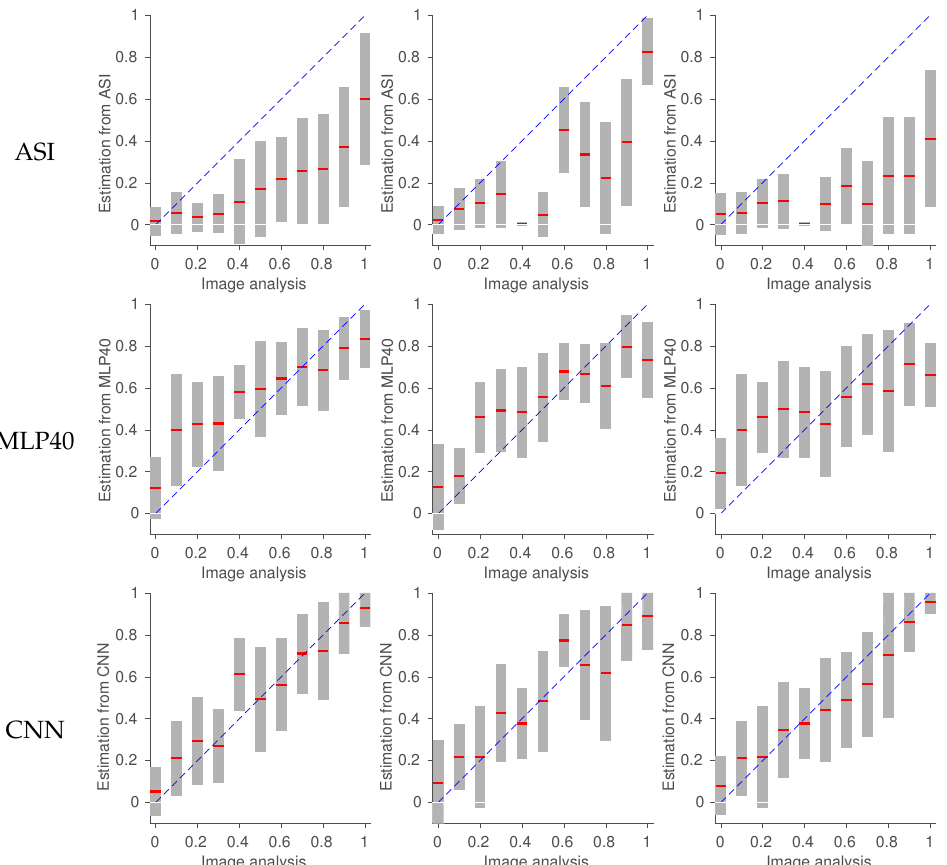
Figure 2. Errors at different ice concentration levels for ASI (1st row), MLP40 (2nd row), and CNN (3rd row) for training (1st column), validation (2nd column) and testing (3rd column) sets. The red lines represent the mean ice concentration, and half length of a bar represents the error standard